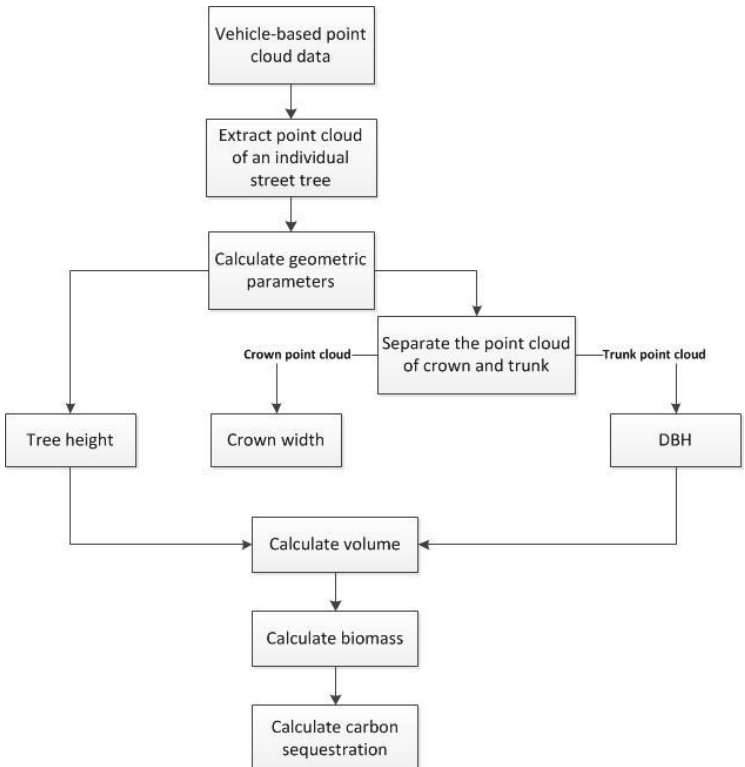
Figure 8. The overall process of calculating carbon